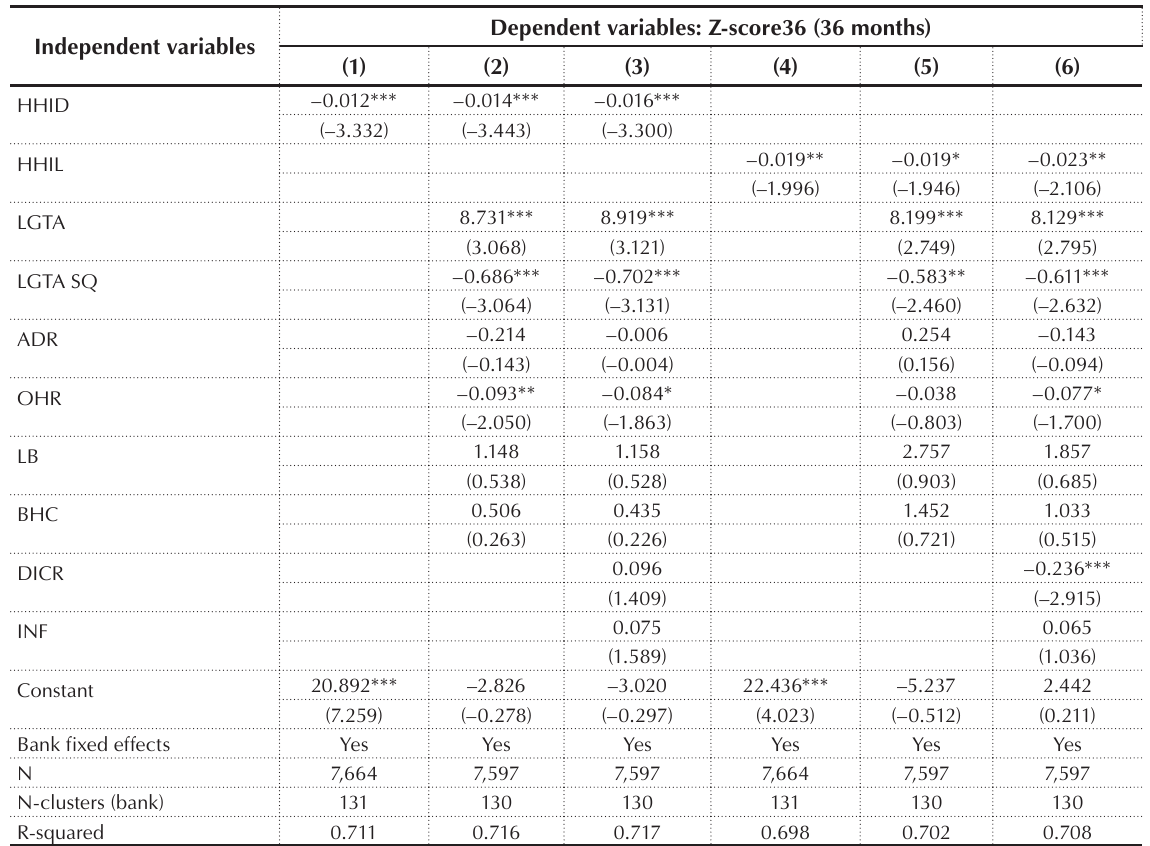
Table 3. (cid:18)(cid:381)(cid:373)(cid:393)(cid:286)(cid:415)(cid:415)(cid:381)(cid:374)(cid:3)(cid:258)(cid:374)(cid:282)(cid:3)(cid:271)(cid:258)(cid:374)(cid:364)(cid:3)(cid:296)(cid:396)(cid:258)(cid:336)(cid:349)(cid:367)(cid:349)(cid:410)(cid:455) Independent